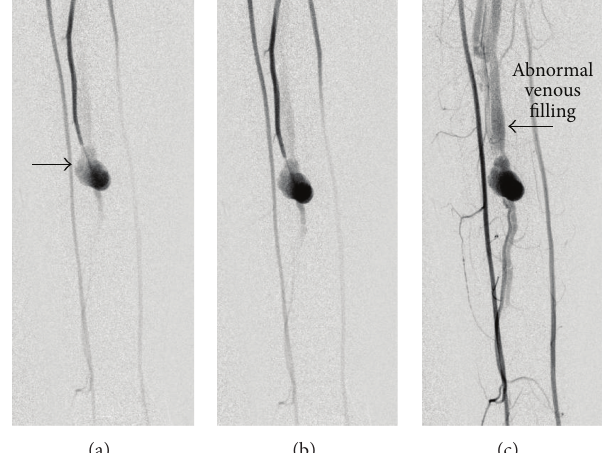
Figure 5: Digital subtraction arteriogram (a–c) shows filling of the wide-necked peroneal pseudoaneurysm (b) with arteriovenous fistula to the peroneal vein